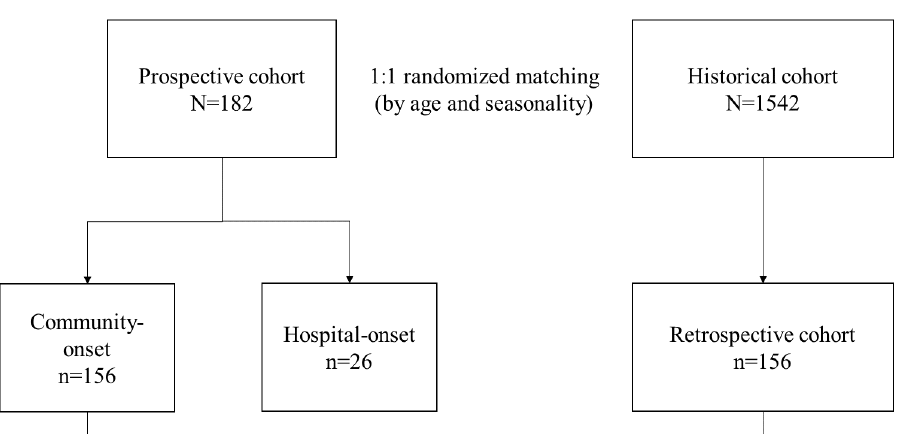
Figure 1. Flow chart of patients included in this study. A total of 214 patients with acute gastroen- teritis were recruited. Patients that were immunocompromised or cases from the same patient that underwent stool studies were excluded (n = 32), and a final 182 patients were included in the prospective cohort.